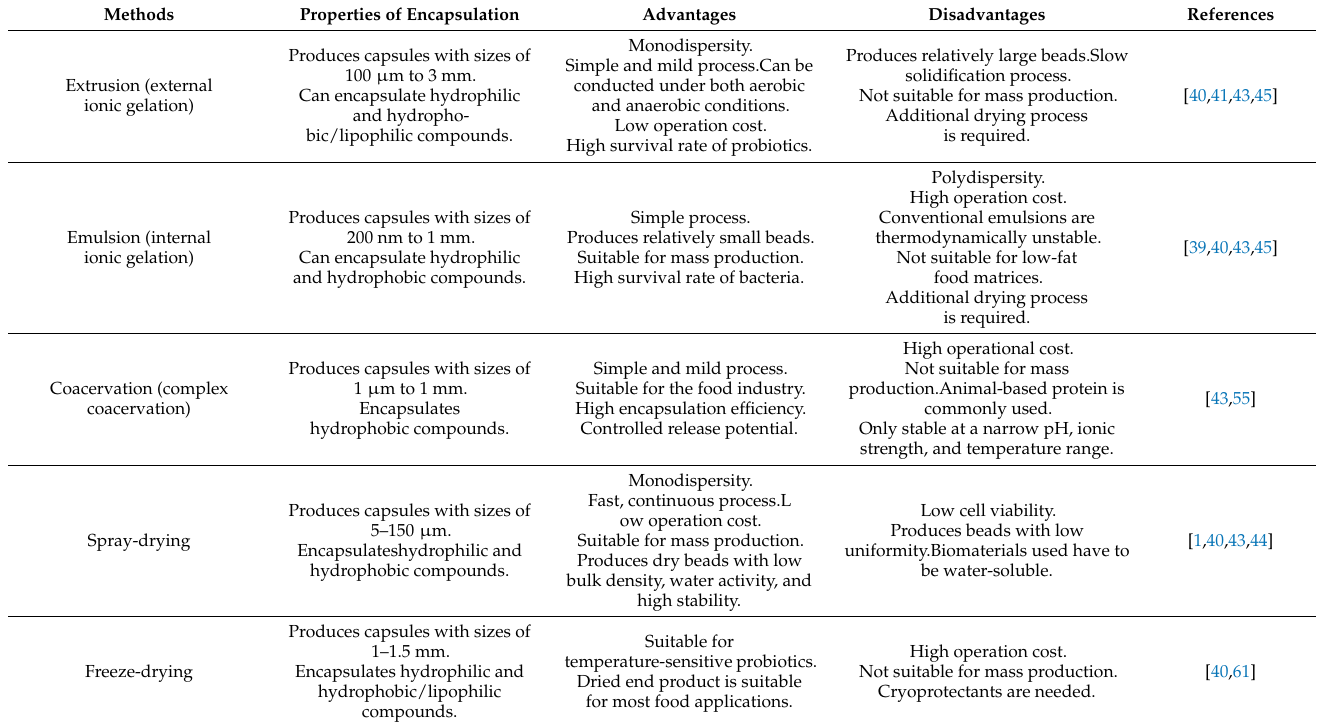
Table 1. Overview of common probiotic encapsulation